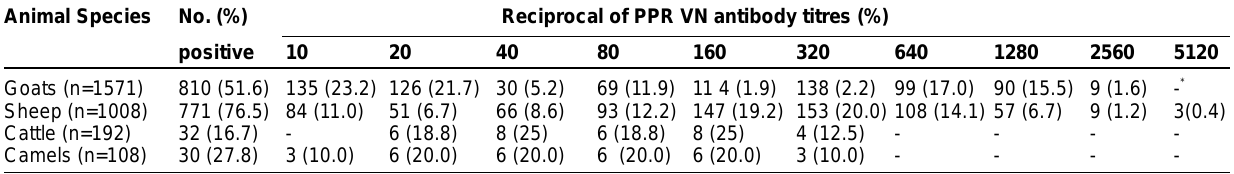
Table-1. Prevalence of PPR VN antibodies in the sera of some ruminants in the semi-arid region of NE Nigeria Animal Species